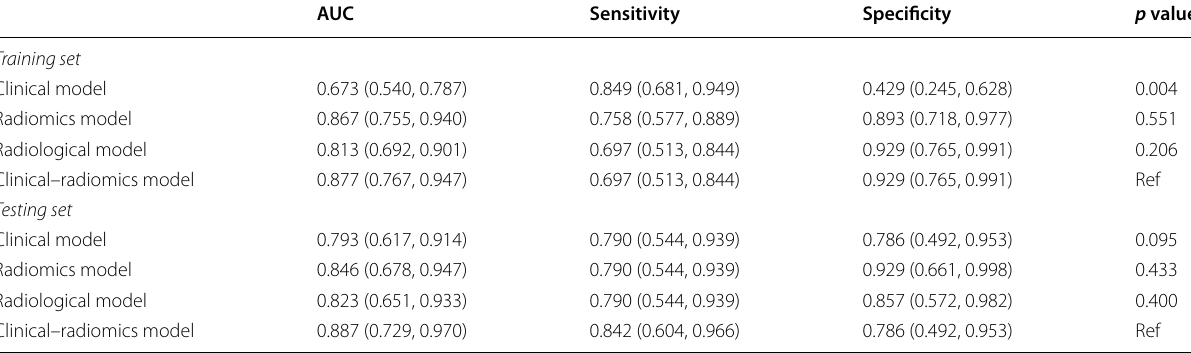
Table 5 Predictive performance of the clinical (age and menopause), radiomics, radiological, and clinical–radiomics models for delineating early stage from advanced-stage cervical